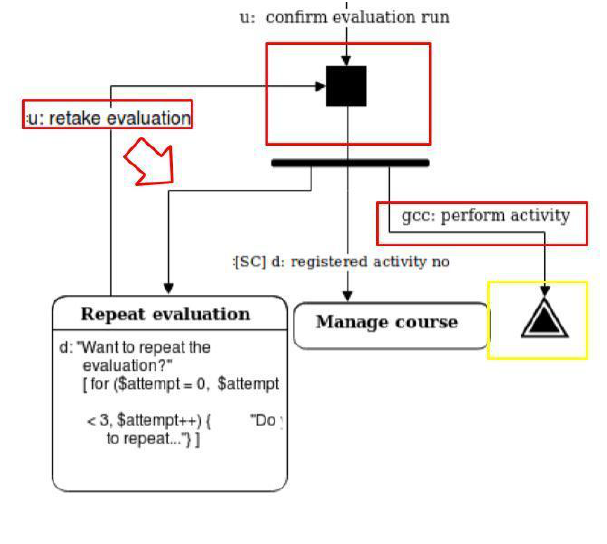
Figure 4. Evaluation